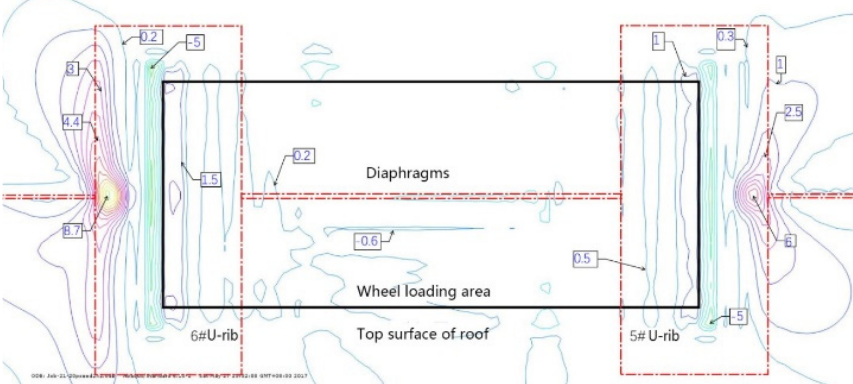
Figure 9. Contour of the principal stress on top surface of roof plate at wheel trace (MPa).